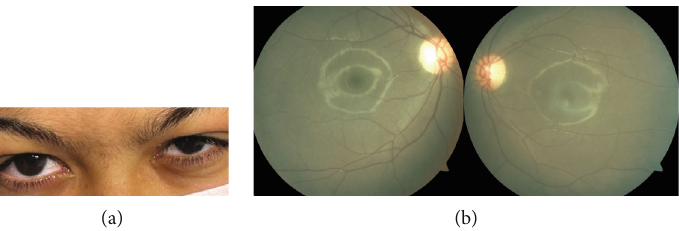
Figure 1: Anterior segment photographs demonstrated mild grade corneal haze bilaterally (a). Fundus photography of the right and left eyes